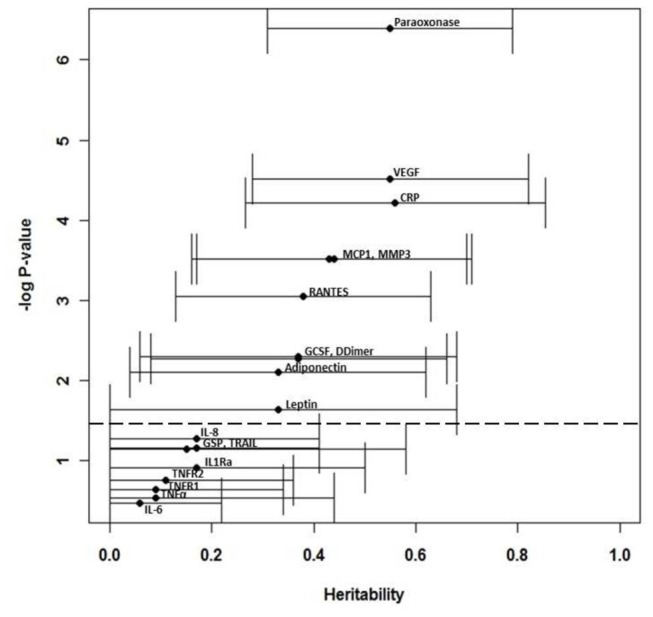
Heritabilities of measured CVD biomarkers.Presented is the distribution of heritability and its corresponding p-value for all 18 biomarkers, with the heritability estimate on the X-axis and the –log base 10 of the associated p-value on the Y-axis. The 95% confidence interval is represented by a horizontal error bar. The threshold for significance is represented by a dashed line.